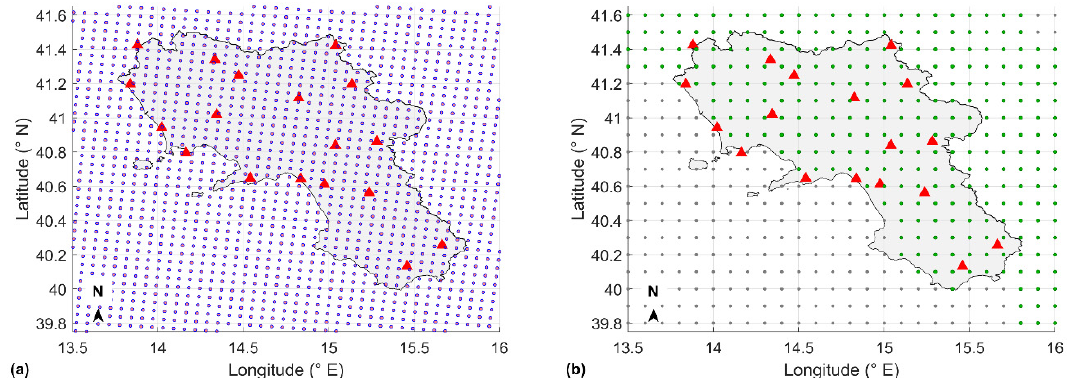
Figure 2. Ground weather station sites (red triangles) and reanalysis grid points ( a ) UERRA MESCAN ‐ SURFEX (UMS), blue circles; ( b ) ERA5 ‐ Land (E5L), green and gray circles. The gray circles are grid points located on the sea, for which E5L does not release data, being the reanalysis focused for the grid points located on the land.